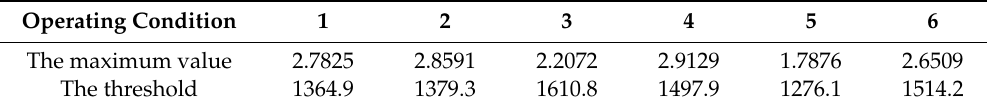
Table 1. The maximum value and threshold of each operating condition.